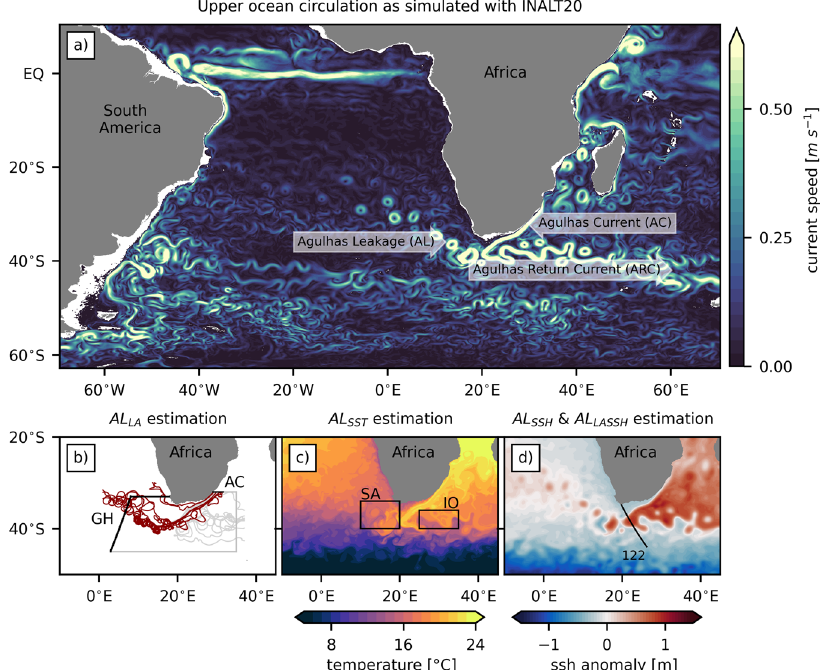
Fig. 1 The eddy-rich ocean model INALT20 is used to estimate Agulhas leakage (AL) via Lagrangian particle tracking (AL LA ), to update an existing method to reconstruct AL from sea surface temperature (AL SST ), and to establish a new Lagrangian method to reconstruct AL from sea surface height (AL LA-SSH ). a 5-day mean snapshot of simulated upper ocean (134 m) current speed. b Release (AC) and sampling (GH) sections for the Lagrangian simulations performed to estimate AL LA , exemplary leakage and no-leakage trajectories are displayed in red and gray lines, respectively. c 5-day mean snapshot of simulated near surface (16 m) temperature, boxes used to calculate the temperature difference between the South Atlantic (SA) and Indian Ocean (IO) used for the AL SST estimation are added. d 5-day mean snapshot of sea surface height (SSH) anomaly (global mean subtracted) used to calculate geostrophic velocities for the new Lagrangian AL LA-SSH estimation, satellite track employed for the old AL SSH estimate by Le Bars et al. (2014) is